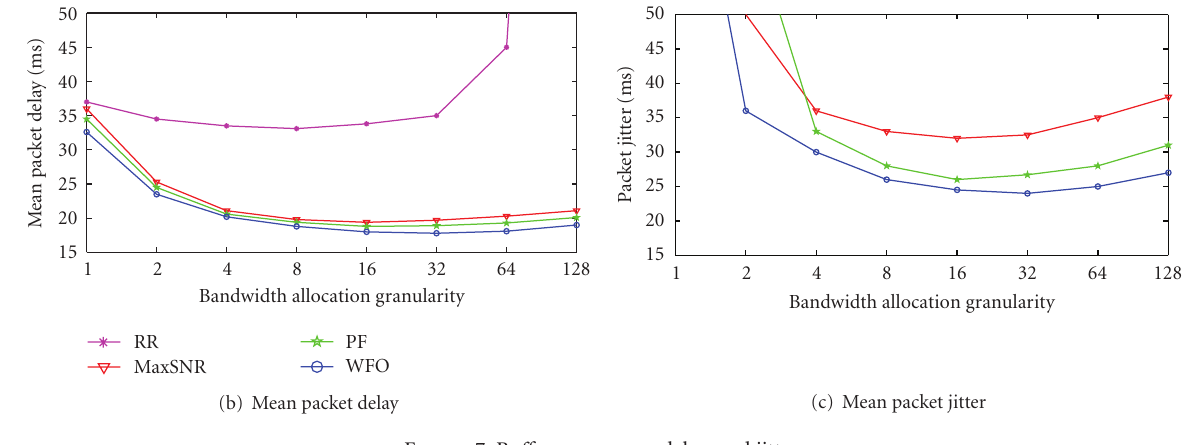
Figure 7: Bu ff er occupancy, delay, and